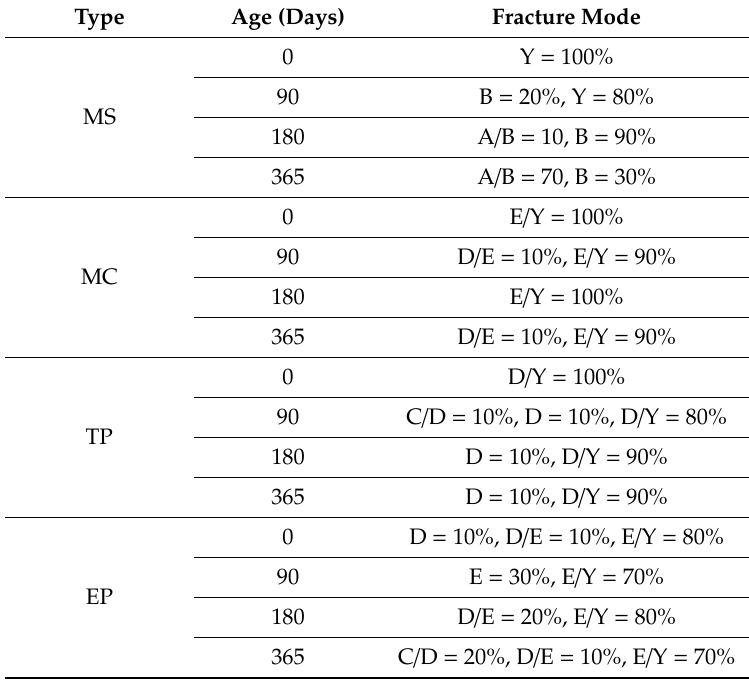
Table 4. Adhesion test results of coating systems exposed to tidal zone.